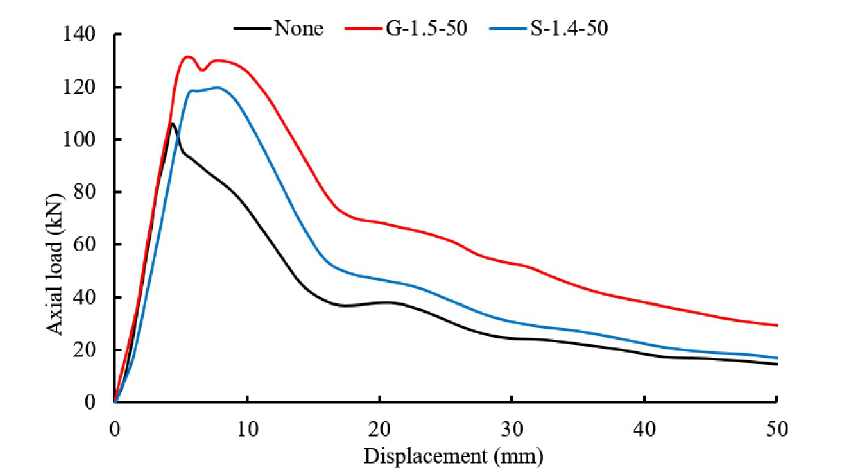
Fig 14. Typical load-displacement curves of the test (G = Grit, S = Shot).